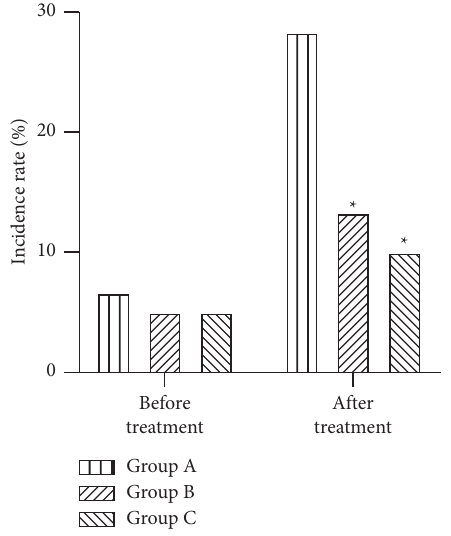
Figure 7: Comparison of 3 groups of the adverse reaction rate and recurrence rate ( n (%)). Compared with group A, ∗ P < 0 .